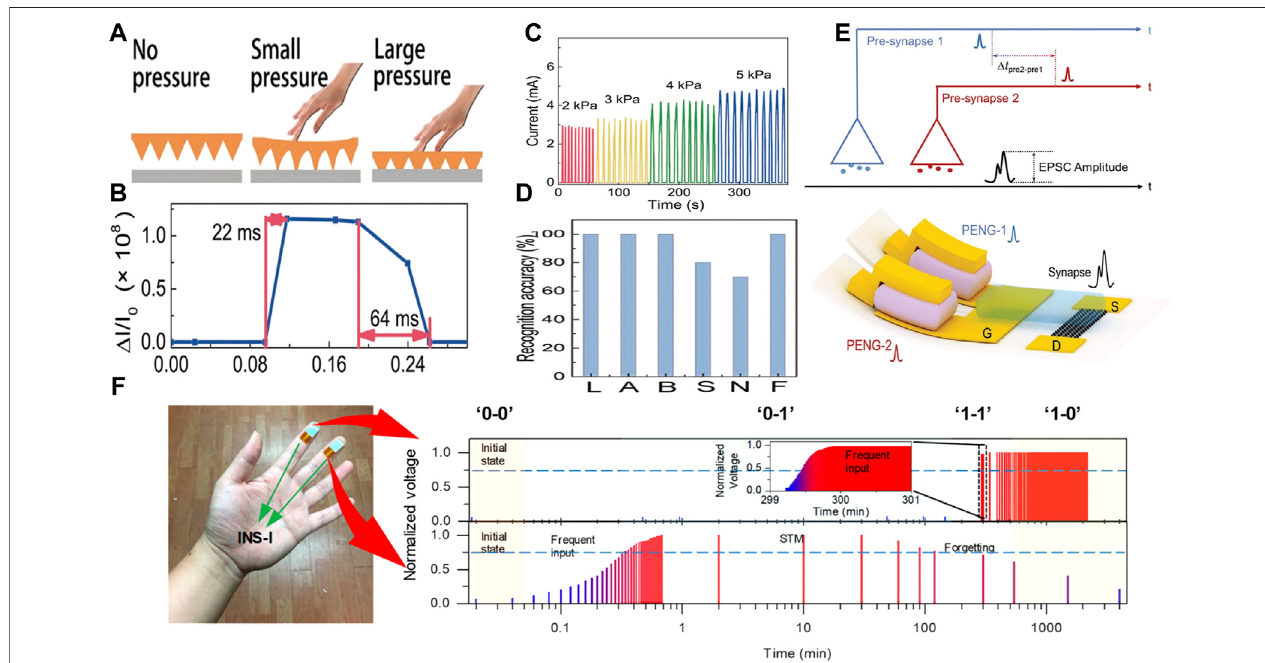
FIGURE 7 | (A) Illustration of the sensor at zero, low, and high pressure. (B) Response and relaxation time of the sensor operating at 1v. (C) Current responses of pressure sensor under pressure pulses from 2 to 5 kPa. (D) Recognition accuracy of each character after 10 times training (adapted from Zhang et al., 2019). (E) Schematic diagram ofthespatiotemporally correlatedspikeEPSC triggered bypresynaptic 1and presynaptic 2and two(PENG-1 and PENG-2) inputs, oneprocessing arti fi cial neural network schematic (adapted from Chen et al., 2019). (F) The device is worn on the fi nger and records the relevant signal output (adapted from Wu et al.,